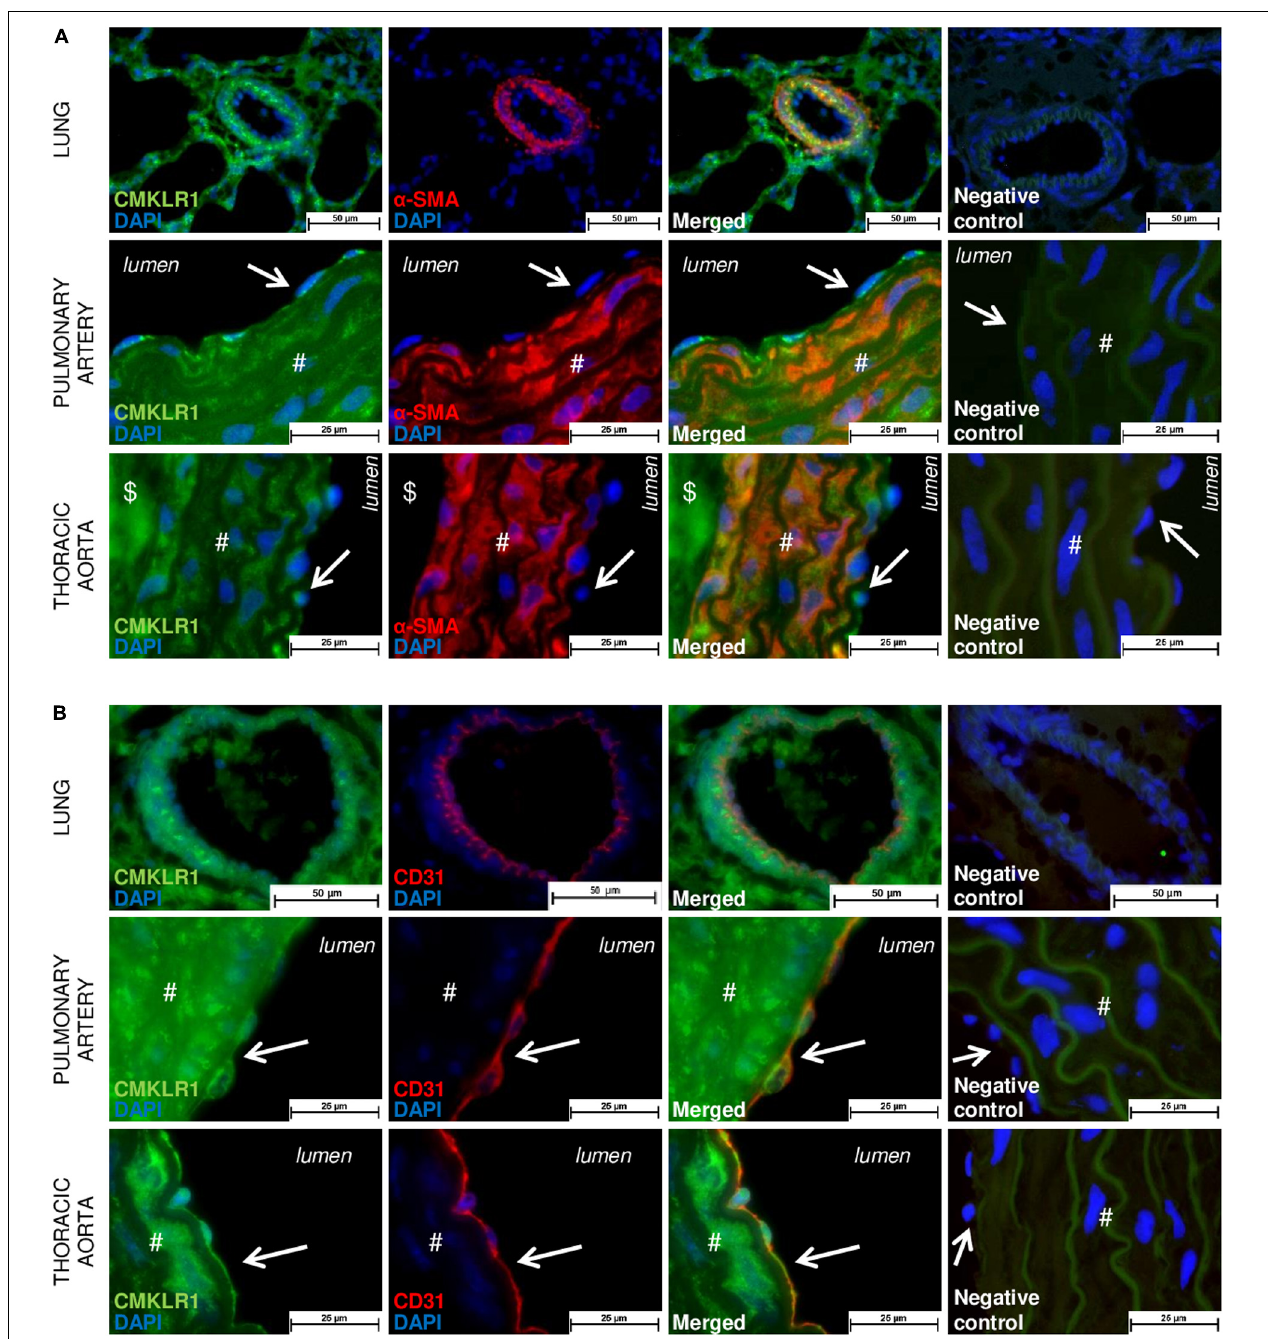
FIGURE 1 | Localization of CMKLR1 in rat pulmonary artery and thoracic aorta. Representative images of double immunofluorescent labeling of CMKLR1 (green) with the smooth muscle-specific marker [red, (A) ] and with the endothelial-specific marker CD31 [red, (B) ] in lungs, as well as in pulmonary artery and thoracic aorta for a total of six fields randomly chosen along each type of tissue from Wistar rats ( n = 4) (both positive for elastic fibers observed in green). Negative control images resulted from the overlay of red, green, and blue (DAPI) channels. Labeling in the vascular intimal, medial, and adventitial layers was, respectively, indicated by arrows, #, and $ in both types of vessels. Scale bars = 50 µ m for the lung and 25 µ m for the pulmonary artery and thoracic aorta sections.